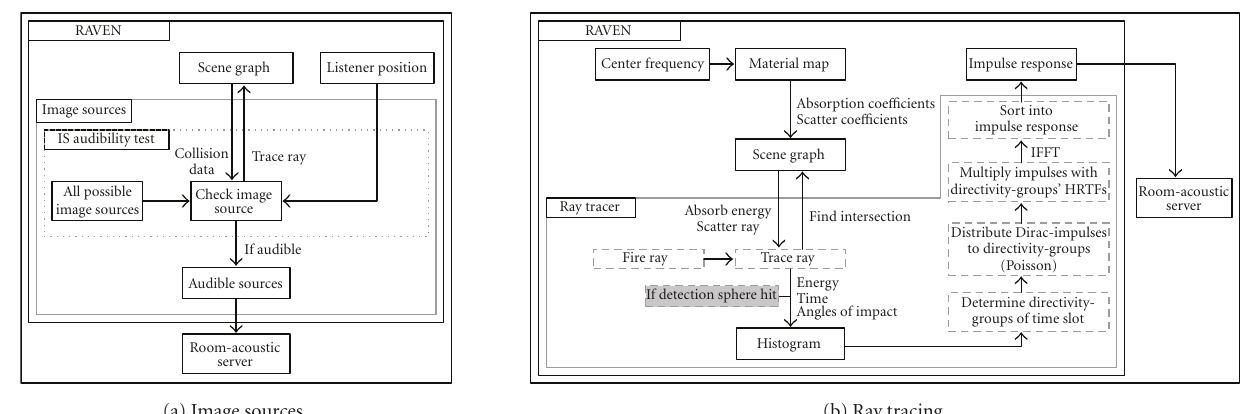
Figure 4: (a) Image source audibility test, (b) estimation of scattering and reverberation.